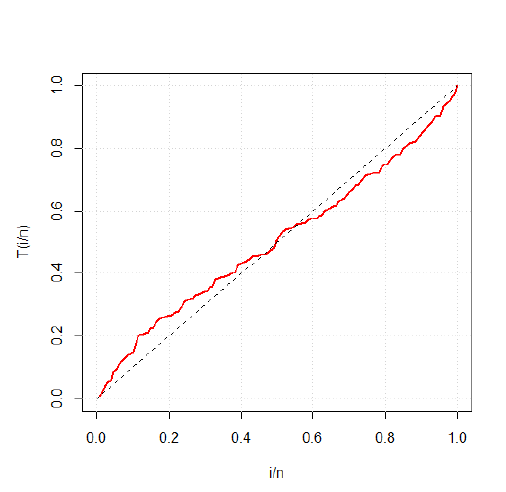
Figure 3 – Empirical TTT plot of the data